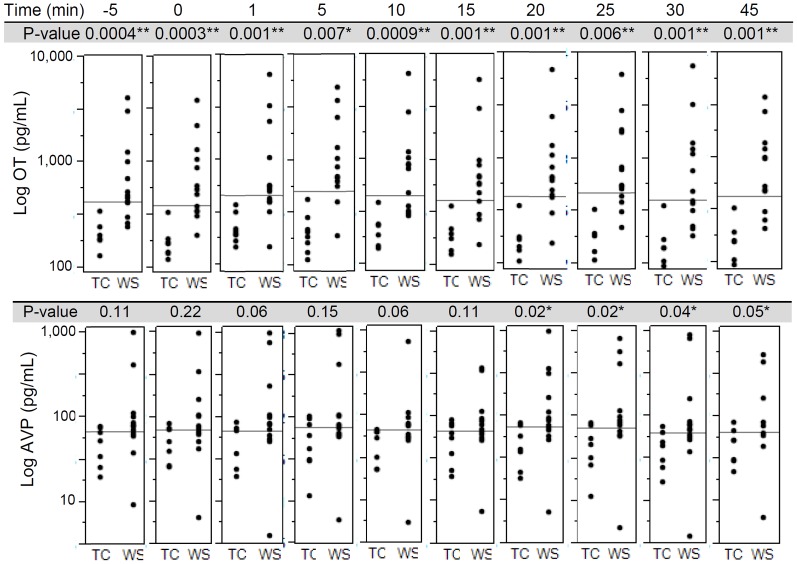
OT levels (pg/mL) measured by enzyme immunoassay in WS cohort are significantly higher than the TC cohort at all ten time points.AVP levels are significantly higher at four out of ten time points. *P<0.05, **P<0.005.